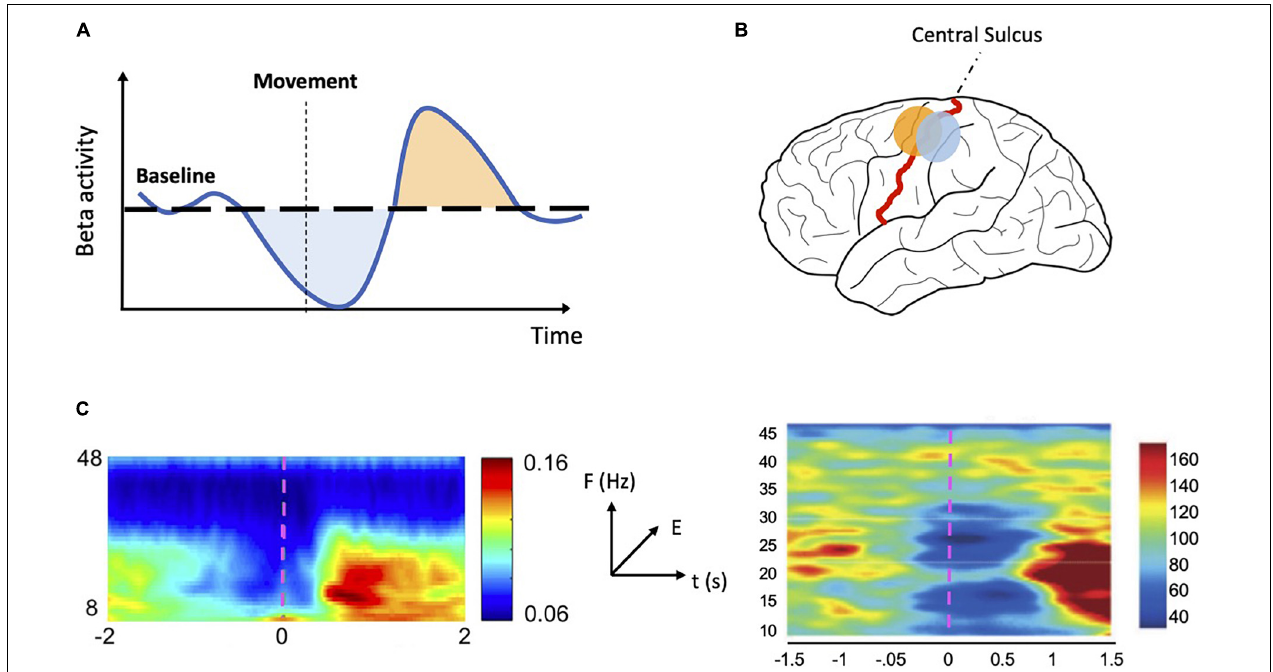
FIGURE 1 | MRBD and PMBR. (A) Schematic representation of sensorimotor beta activity. During a motor task beta activity drops below baseline (MRBD— light blue shaded area ) just prior to and during movement execution. After movement ends, beta activity increases rapidly (PMBR— light orange shaded area ) before slowly returning to baseline level. (B) Schematic representation of MRBD and PMBR spatial distribution. MRBD ( light blue dot ) is commonly localized to the postcentral gyrus whereas PMBR ( light orange dot ) is often localized to the precentral gyrus. (C) Time-frequency plots showing MRBD and PMBR in M1 ( left —reproduced and adapted with permission from Little et al., 2019) and STN ( right —reproduced and adapted with permission from Alegre et al., 2005). Both plots show oscillatory activity changes specific to the beta band (13–30 Hz) in the period prior to movement and following movement termination. The color scale indicates relative energy changes with respect to baseline level (blue colors indicate a decrease; red colors indicate an increase). The movement begins at time 0 ( magenta dashed line ). MRBD: movement related beta decrease; PMBR, post-movement beta rebound; M1: primary motor cortex; STN, subthalamic